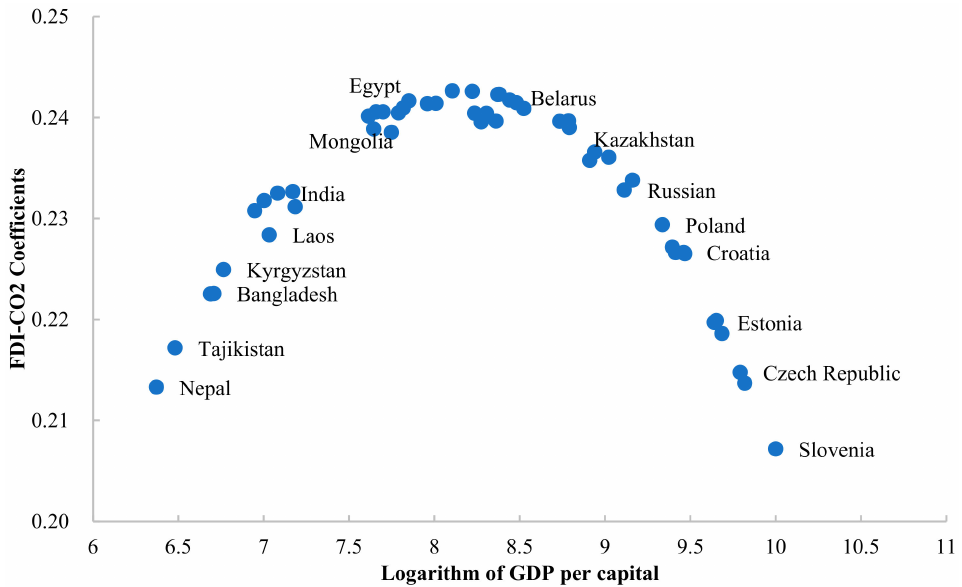
Figure 2. FDI-CO 2 coefficients of Belt and Road countries (GDP per capita